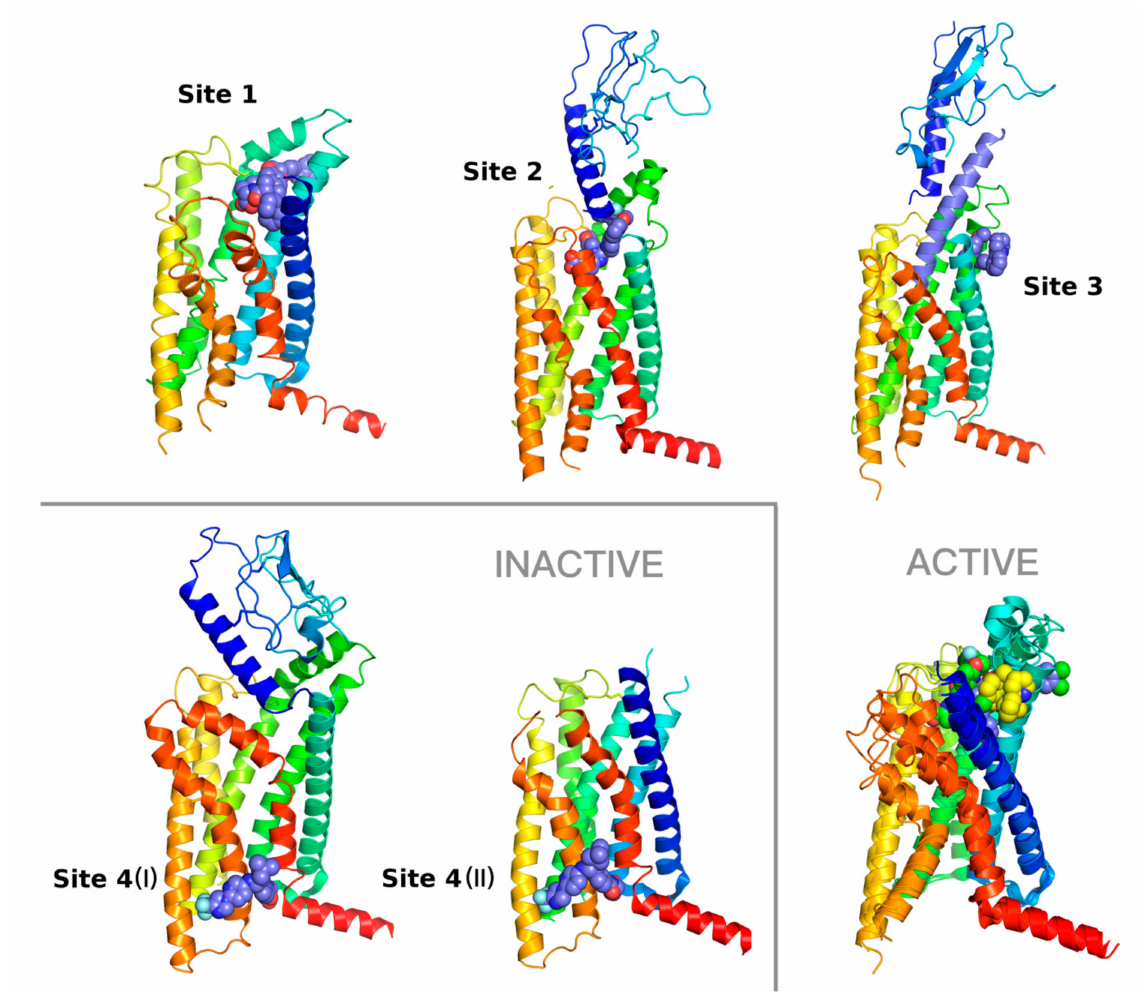
Figure 1. Diversity of small-molecule binding sites in GLP-1R. Binding site 1—6ORV [13], site 2—7C2E [14], site 3—6VCB (Bueno et al. 2020) with an included peptide agonist shown in blue, site 4 (I) (left)—6LN2 (Wu et al. 2020), site 4 (II) (right)—5VEW [15]. Binding sites 1 and 3 corresponds to allosteric sites with positive allosteric modulators (PAMs), site 2 to the orthosteric site with a full agonist. The binding site 4, showed here in 6LN2 (4 (I)) and 5VEW (4 (II)) structures, is occupied by negative allosteric modulators (NAMs). In three cases (2, 3, and 4 (I)), an extracellular domain (ECD) of GLP-1R is also shown. Additionally, an overlay of three active conformations of the GLP-1R receptor with binding sites 1–3 is shown on the right bottom. In this additional superposition of GLP-1R structures the site 1 ligand is shown in blue, the site 2 ligand in green, and the site 3 ligand in yellow. The intracellular part of the receptor that interacts with a G protein complex is nearly identical in all these three superposed structures. However, the extracellular part of GLP-1R differs significantly from binding sites 1 to 3. The most significant differences can be observed in the top region of TMH7 (red), the top region of TMH1 (blue), and in the extracellular loop EC1 region of the receptor that forms a small helix. The structural diversity observed in conformations of EC3 is mostly due to differences in in the top region of TMH7, which is much closer to the ligand-binding sites than TMH6